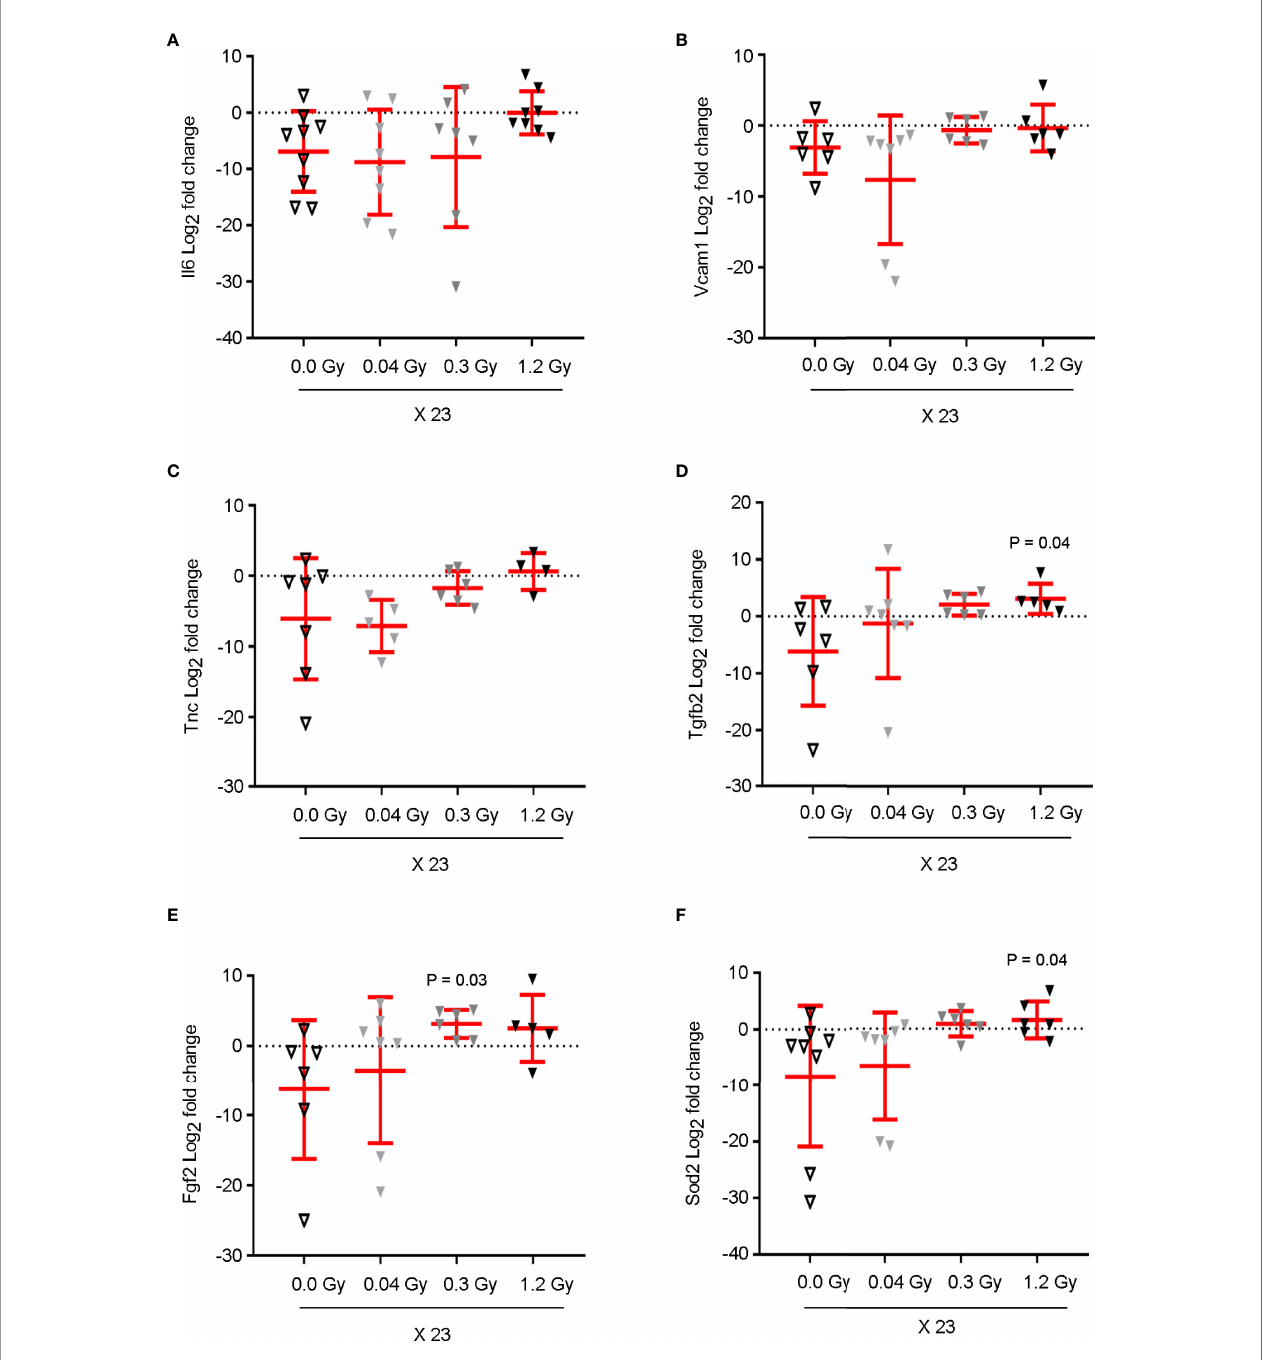
FIGURE 4 | Cumulative doses of 6.9 and 27.6 Gy upregulate the mRNA expression of pro-in fl ammatory, pro- fi brotic, and oxidative stress markers in cardiac tissue, prior to myocardial strain dysfunction. The mRNA expression of (A) Il6 , (B) Vcam1 , (C) Tnc , (D) Tgfb2 , (E) Fgf2 , and (F) Sod2 from the cardiac tissue of rats, sham- irradiated or irradiated with 0.04, 0.3, or 1.2 Gy for 23 daily fractions, was quanti fi ed by qRT-PCR. Cycle threshold values were normalized to 18S to obtain relative gene expression values. Data (mean ± SD) represents the Log 2 of fold change in gene expression for each animal, in triplicate measurements relative to the fold change average of the sham-irradiated (0.0 Gy) group; n = 6 – 9 rats per group. Results show (A) an increasing trend of Il6 expression, exclusively in response to 1.2 Gy. (B – F) The levels of Vcam1 , Tnc , Tgfb2 , Fgf2 , and Sod2 present a signi fi cant augmentation or increasing trend in response to the daily doses of 0.3 and 1.2